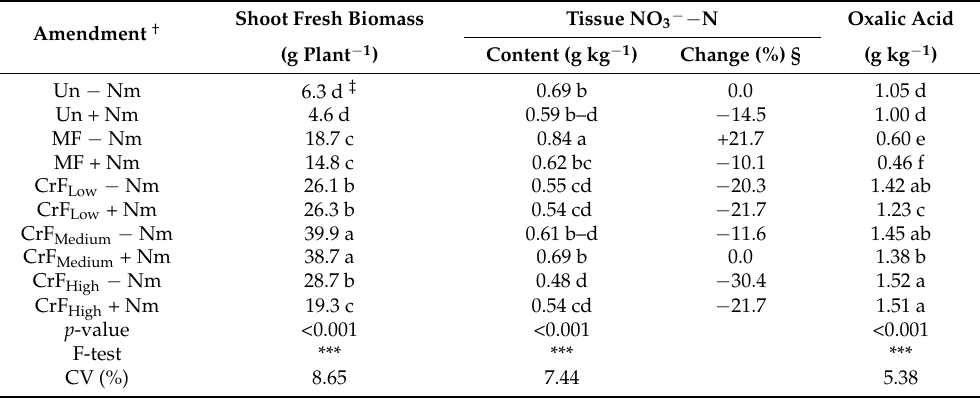
Table 3. Shoot fresh biomass, tissue NO 3 − − N, and oxalic acid contents of amaranth as affected by the combined uses of different rates of cricket frass and neem seed extract.